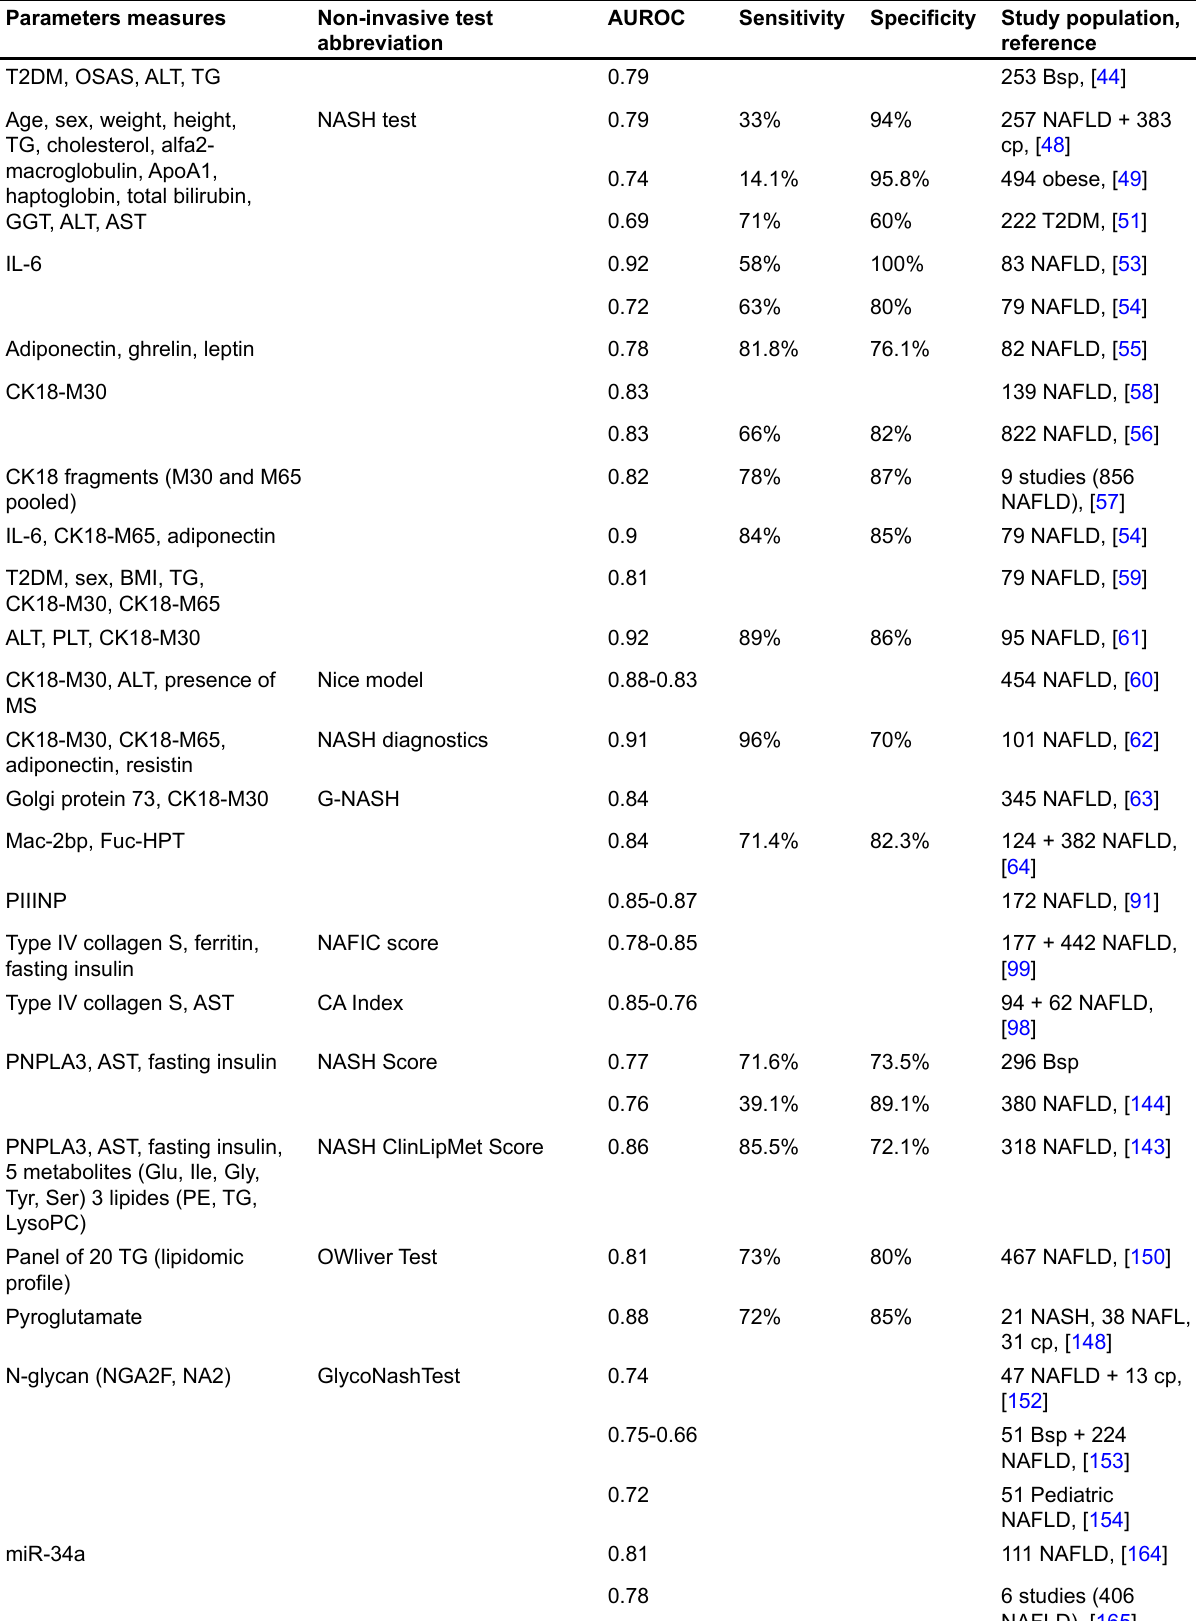
Table 1. Summary of biomarkers for NASH diagnosis in patients with NAFLD ( continued ) Parameters